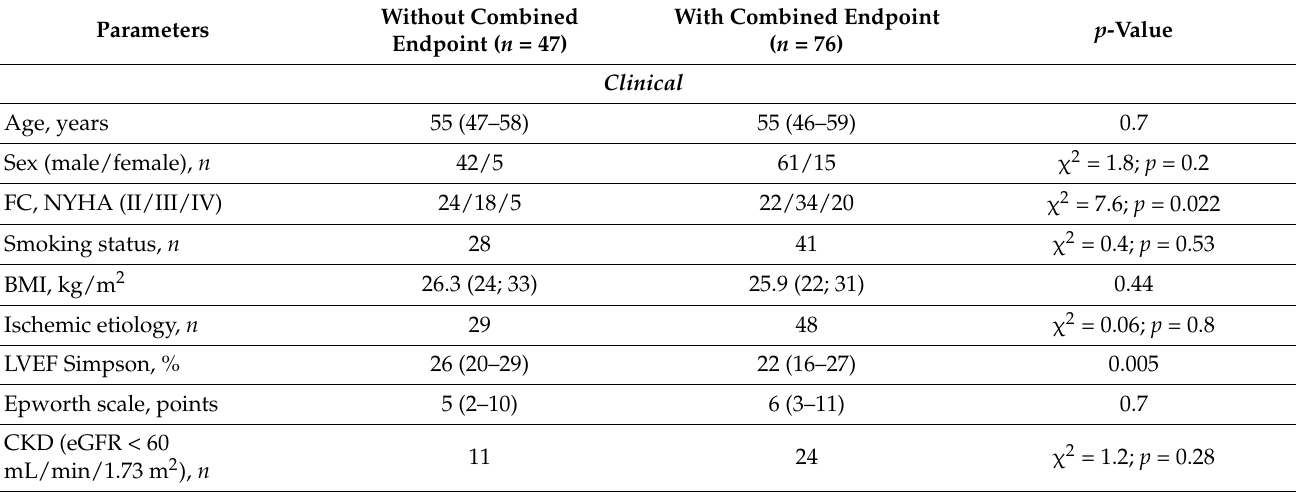
Table 2. Comparison of patients with and without combined